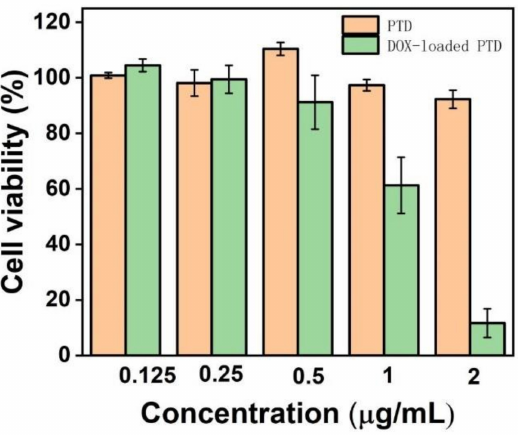
Figure 3. Survival rate of breast cancer cells with different concentrations of blank and DOX-loaded PTD solution within 24